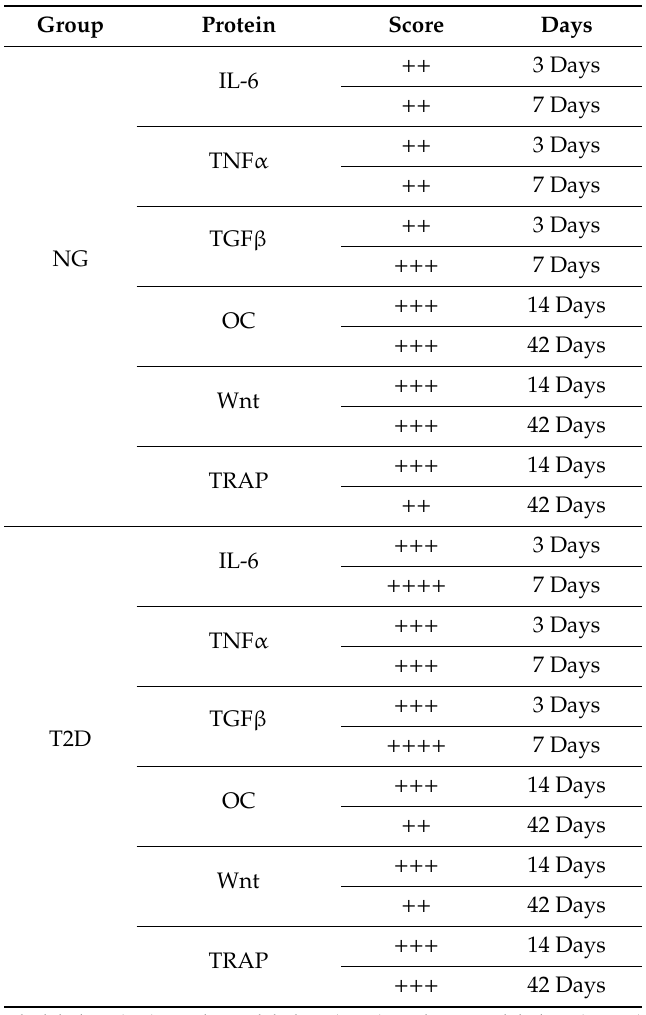
Table 4. Scores of NG and T2D immunolabeling analysis. Antibodies against IL-6, TNF α , TGF β , OC, Wnt and